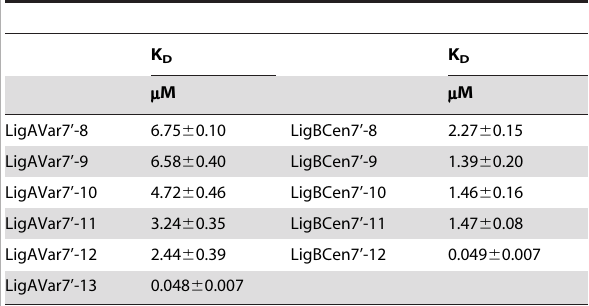
Table 2. The dissociation constants of GBD and truncated Lig proteins interactions determined by ELISA.